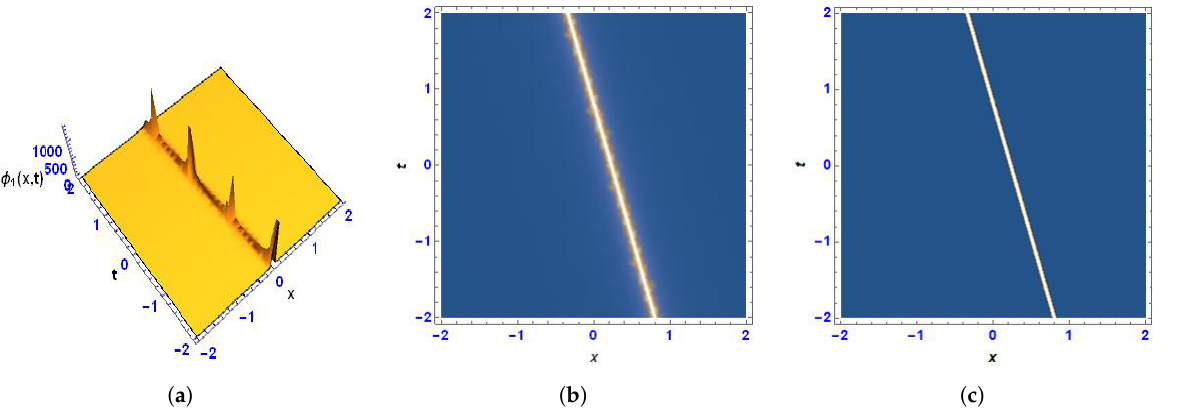
Figure 5. ( a ) Three-dimensional, ( b ) density, and ( c ) contour images of (14) under the values